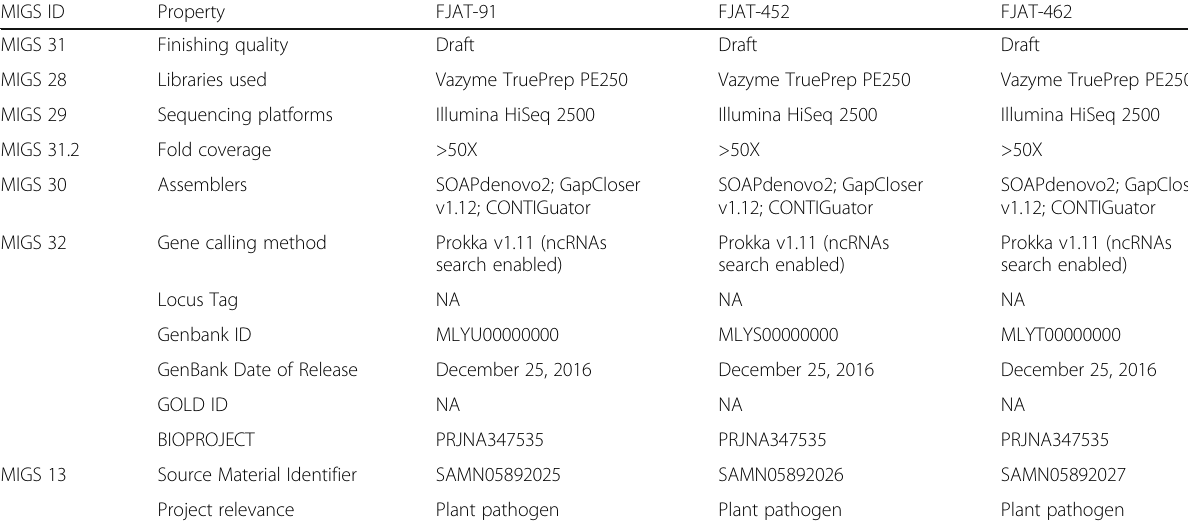
Table 4 Project information